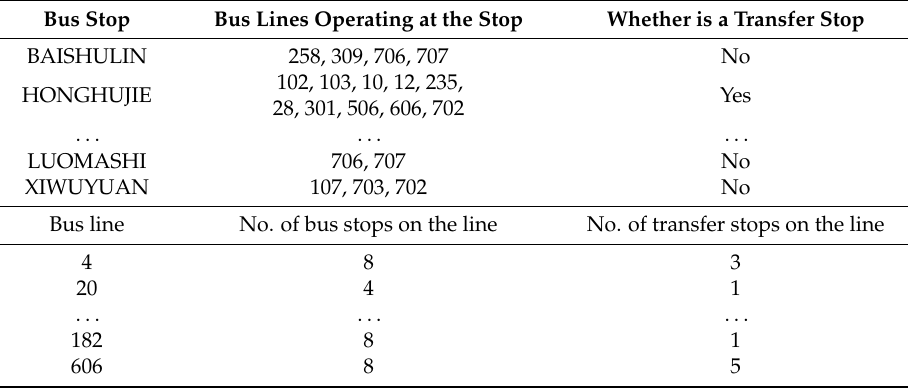
Table 2. Key data on the Bus–Metro